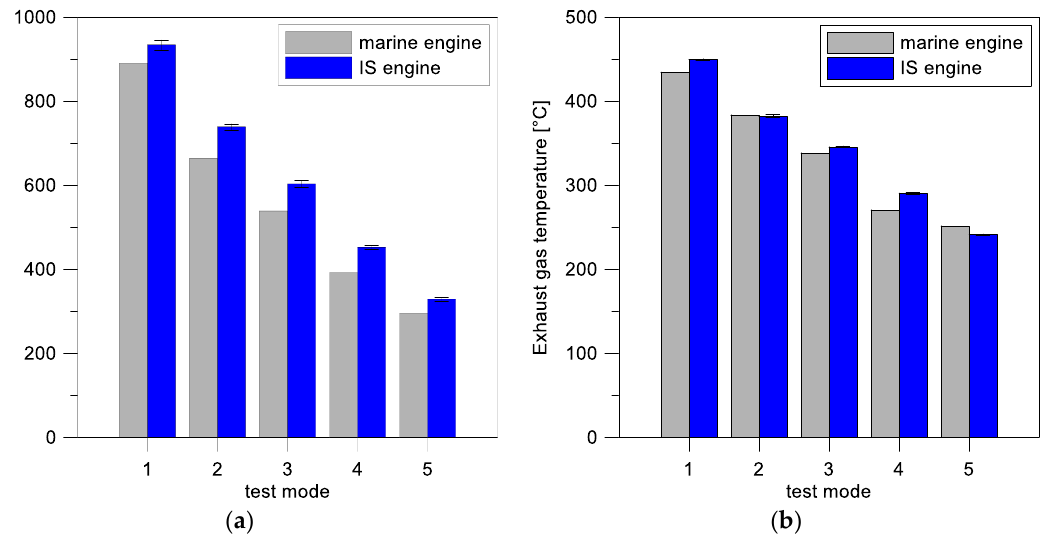
Figure 7. Comparison of ( a ) NO x and ( b ) exhaust temperatures between marine and intermediate- scale engine in the five selected modes.